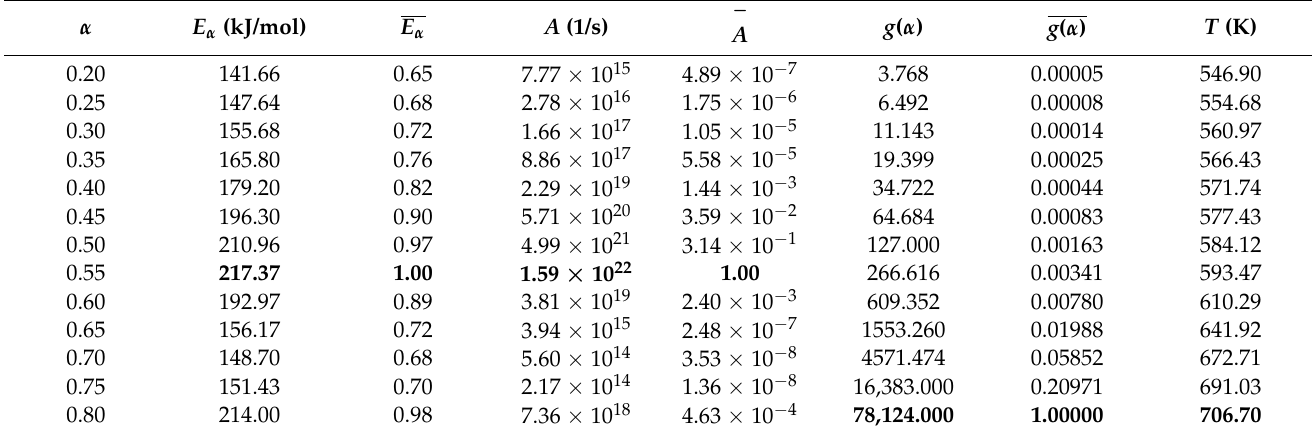
Table 4. Kinetic parameters in absolute and normalized